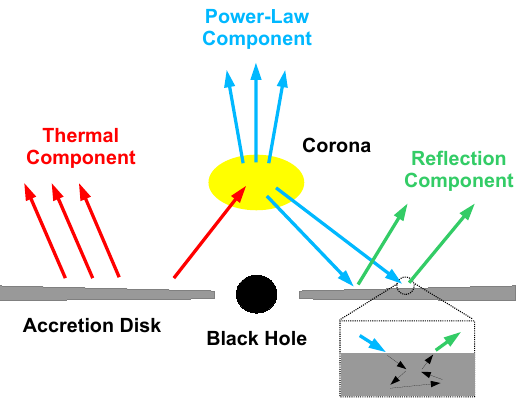
Figure 1. Disk-corona